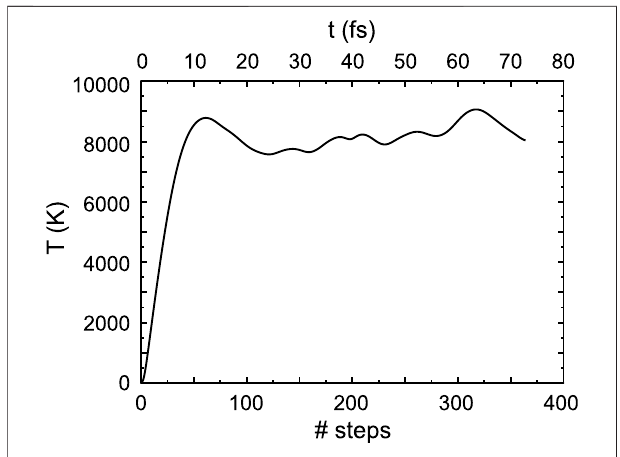
FIGURE 6 | Microcanonical DFT-MD simulation of the fi rst tens of femtoseconds of laser irradiated cryogenic molecular hydrogen. ρ =0.07 g/ cm 3 , T e = 10 eV, T 0 i (cid:2) 25